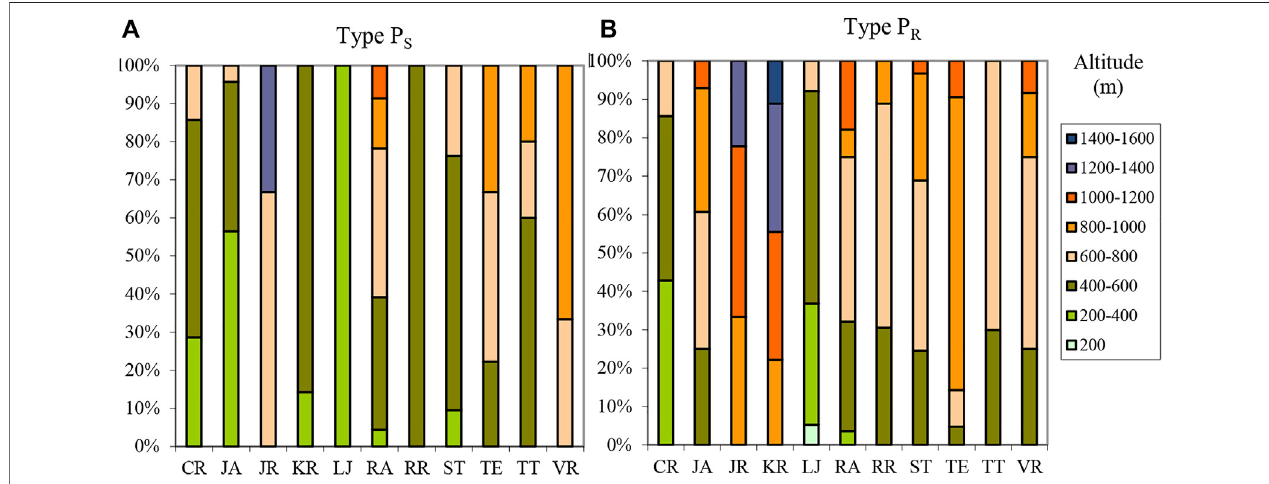
FIGURE 5 | Altitude distribution of rural settlements Stagnant type of population change (Type P S ) in mountain watersheds (A) ; Altitude distribution of rural settlements Regressive type of population change (Type P R ) in mountain watersheds (B) .